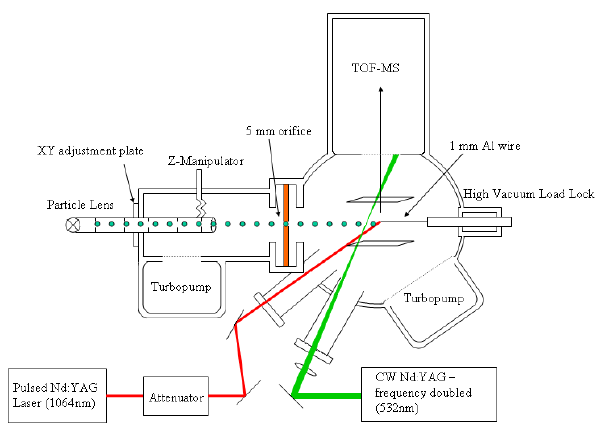
Fig. 1. Schematic drawing of